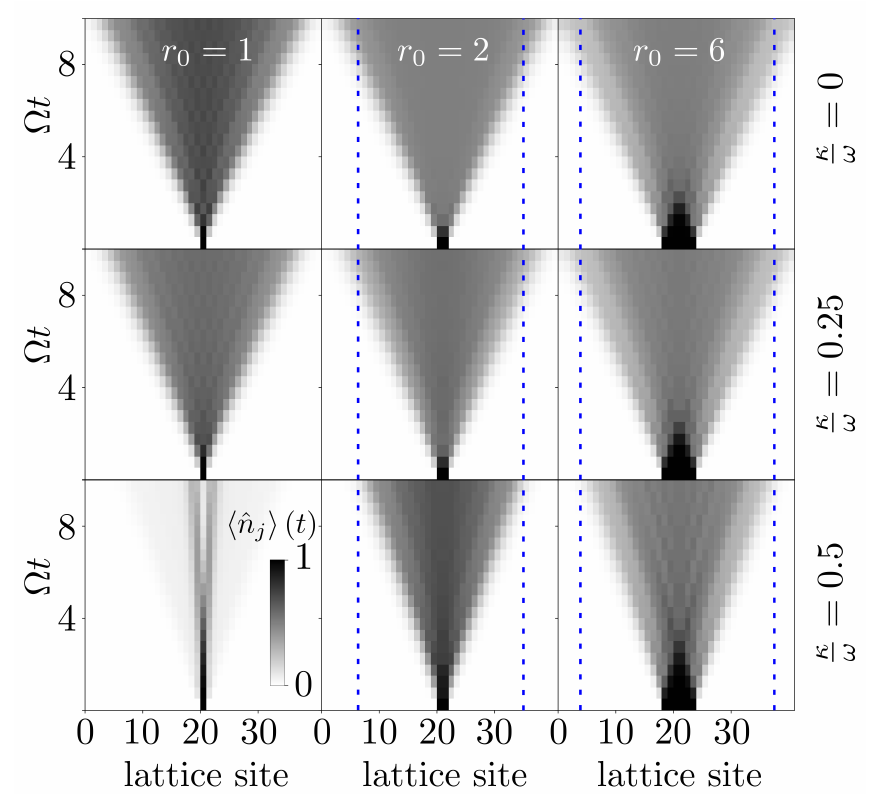
consecutive initial excitations : Figure 3: Dynamics of a Rydberg cluster with r 0 〉 ( t ) for different values of the Time evolution of the Rydberg excitation density 〈 ˆ n j initial Rydberg cluster size, r , and spin-phonon coupling strength, κ/ω . Visible 0 is a ballistic expansion, which becomes slower for large values of the spin-phonon coupling constant κ . An almost complete inhibition of expansion appears in the case = 1, as the strong repulsive potential makes transitions to propagating continuum r 0 > 1 also slows states off-resonant. The propagation of the Rydberg clusters with r 0 down with increasing spin-phonon interaction. This is due to the decrease of the hopping rate J . The dotted blue lines are used to enhance the visibility of this q